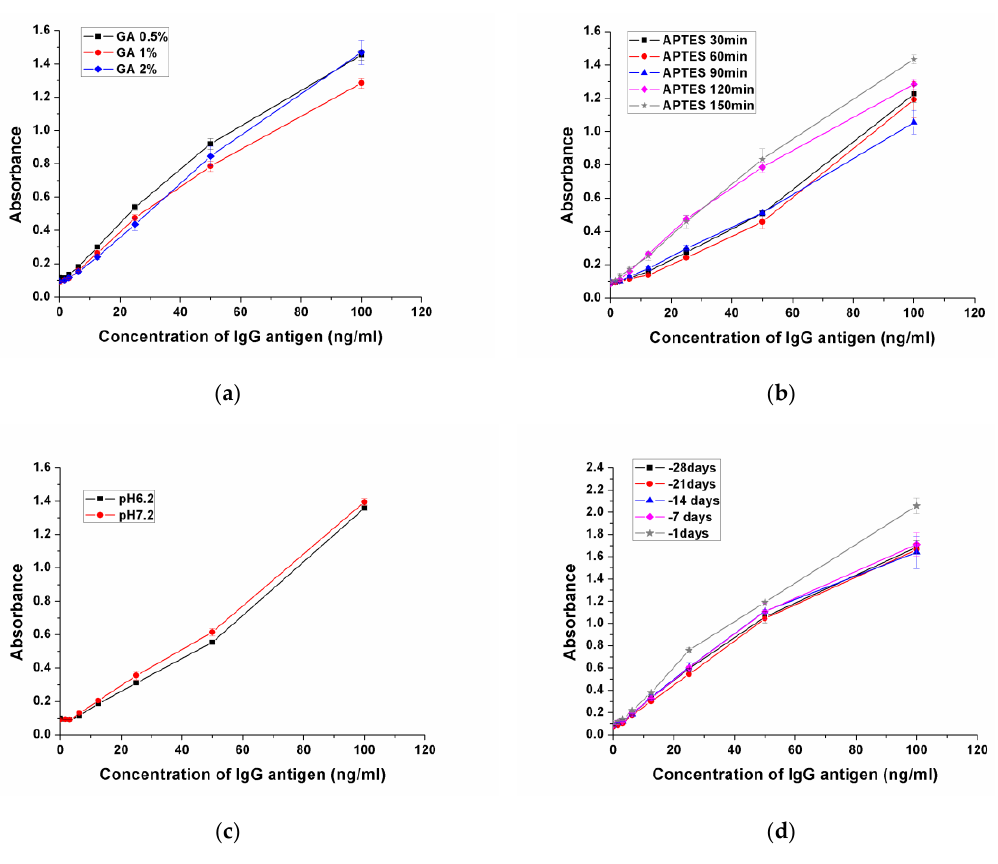
Figure 2. Changes in calibration linearity against different concentrations of IgG. Under conditions of ( a ) APTES incubation times of 30 ~ 150 min, ( b ) the amount of Glutaraldehyde, ( c ) pH of 6.2 and 7.2, and ( d ) different storage days from one to 28 days.